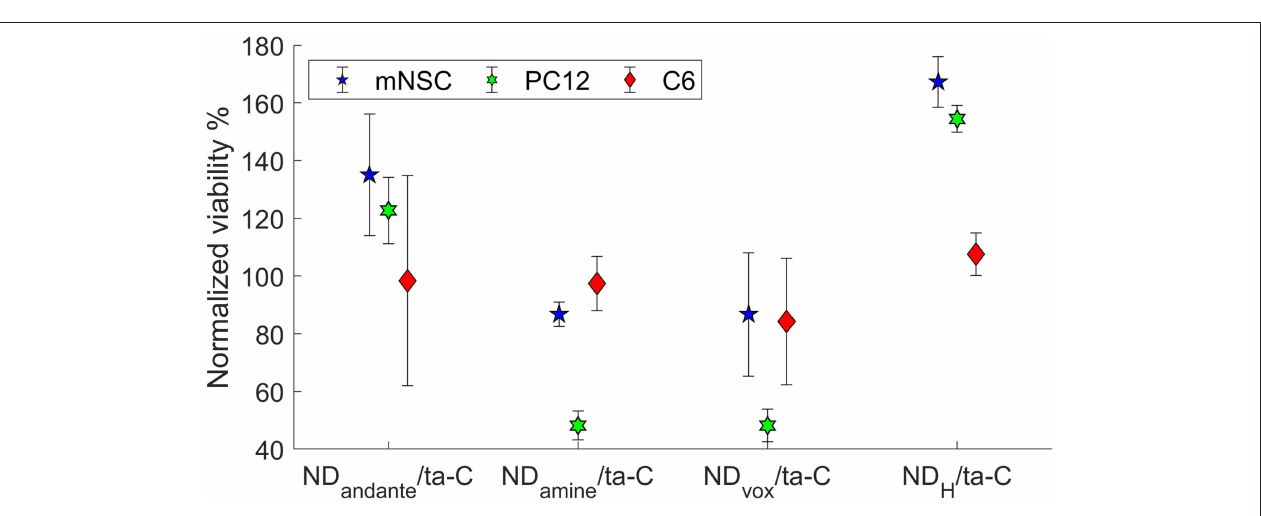
FIGURE 2 | Viability (MTT) of cells on functionalized hybrid ND/ta-C surfaces. Viability is normalized to ta-C. Modified from Peltola et al.